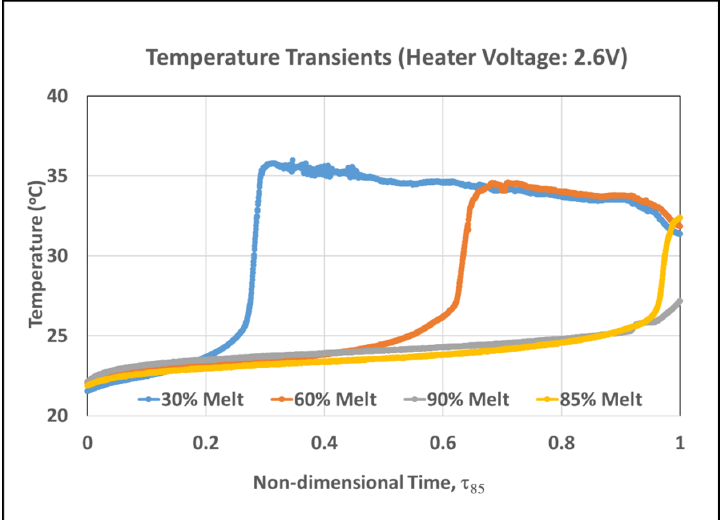
Figure 7. Temperature transients from the three thermocouples mounted within the mass of PCM in the experimental apparatus for a heater input of 2.6 V, plotted as a function of the non-dimensional time ( τ ).